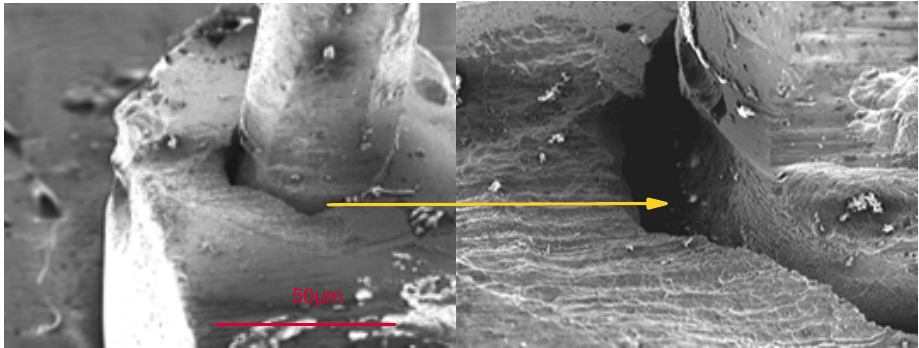
Figure 27. Unbroken part of the laser welded pin assembly. Crevice corrosion. Scale = 50 μm. Sample #4.